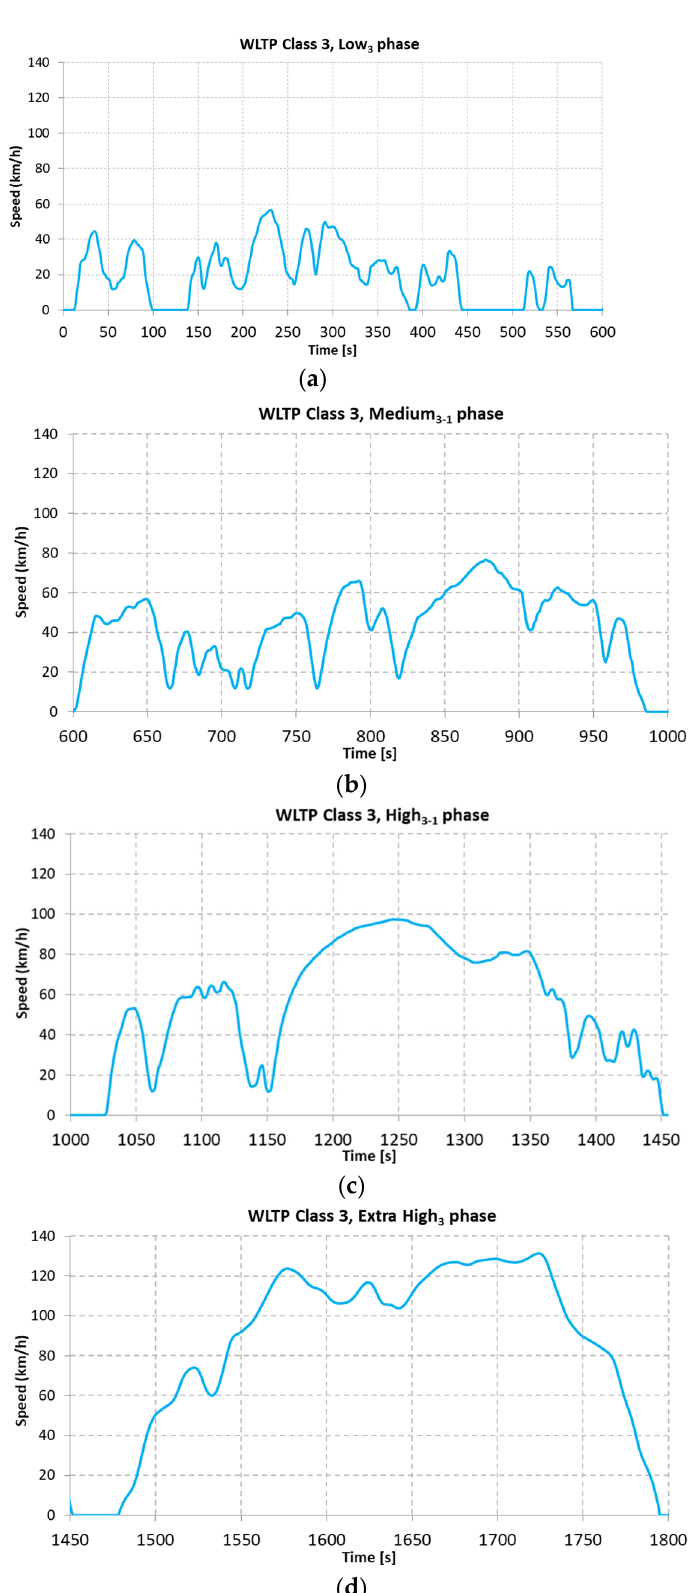
Figure 7. WLTP test cycle, in accordance with Commission Regulation (EU) 2017/1151 [33], where: ( a ) phase Low 3 (A1/7); ( b ) Medium 3-1 (A1/8) phase; ( c ) phase High 3-1 (A1/10); and ( d ) Extra High 3 phase (A1/12).